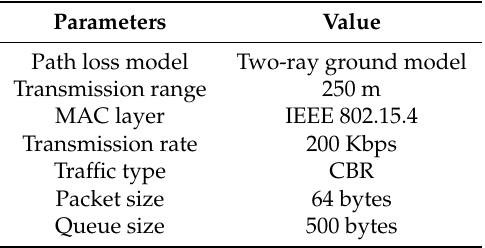
Table 1. Simulation